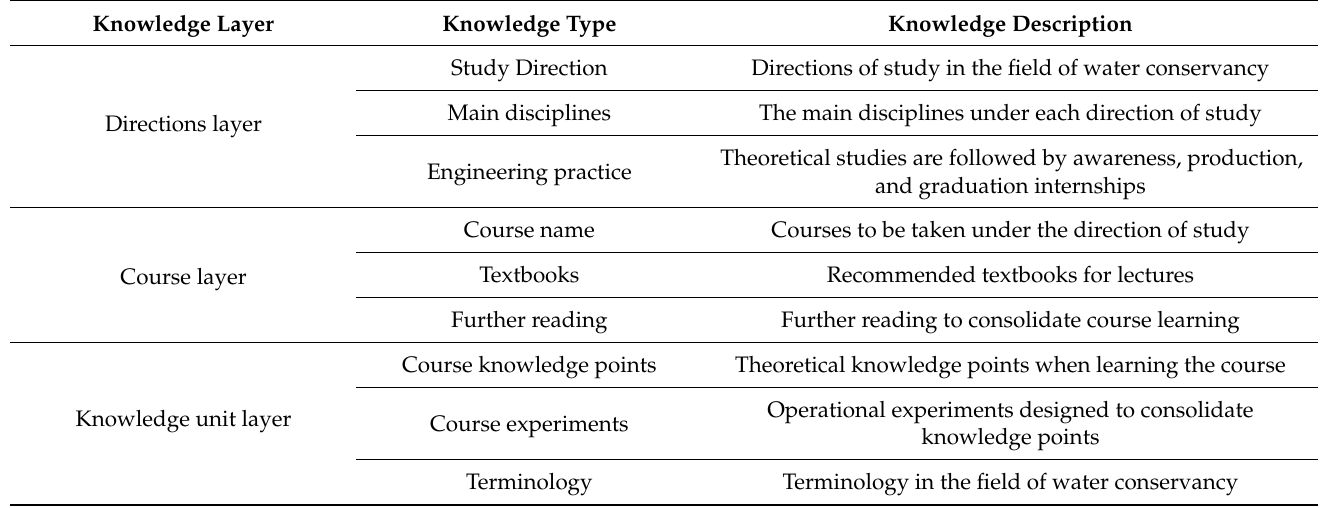
Table 1. Definition of the knowledge